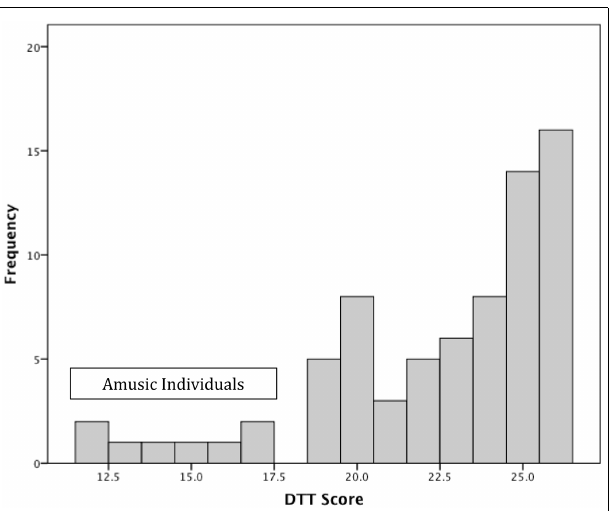
FIGURE 1 | Distribution of scores on the distorted tunes test (DTT). Scores ≤ 18 are considered amusic.